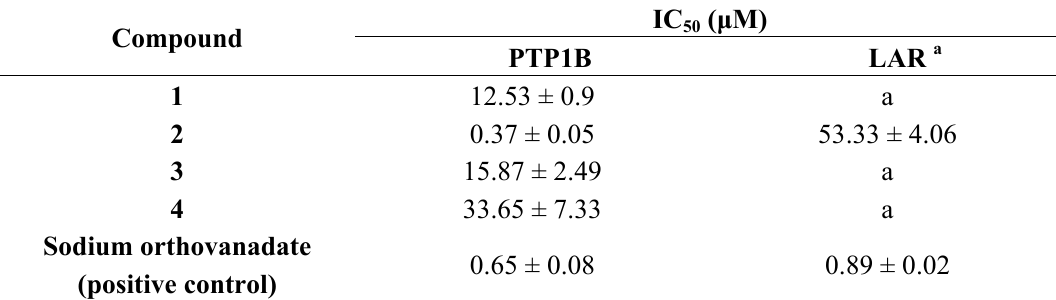
Table 2. Potency and selectivity of penostatin derivatives PTP1B